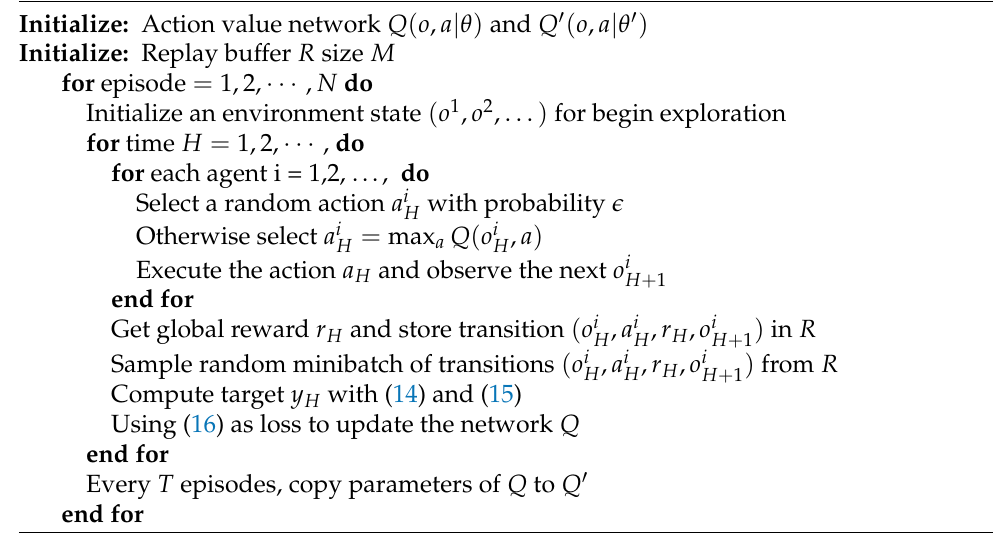
Algorithm 1 Training Process of RL